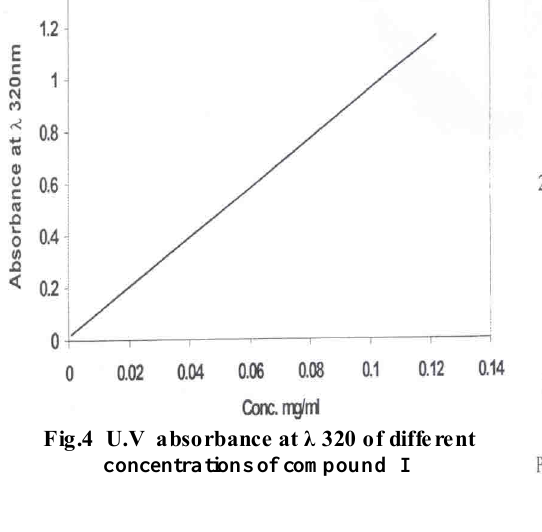
Fig.4 U.V absorbance at λ 320 of different concentrations of compound